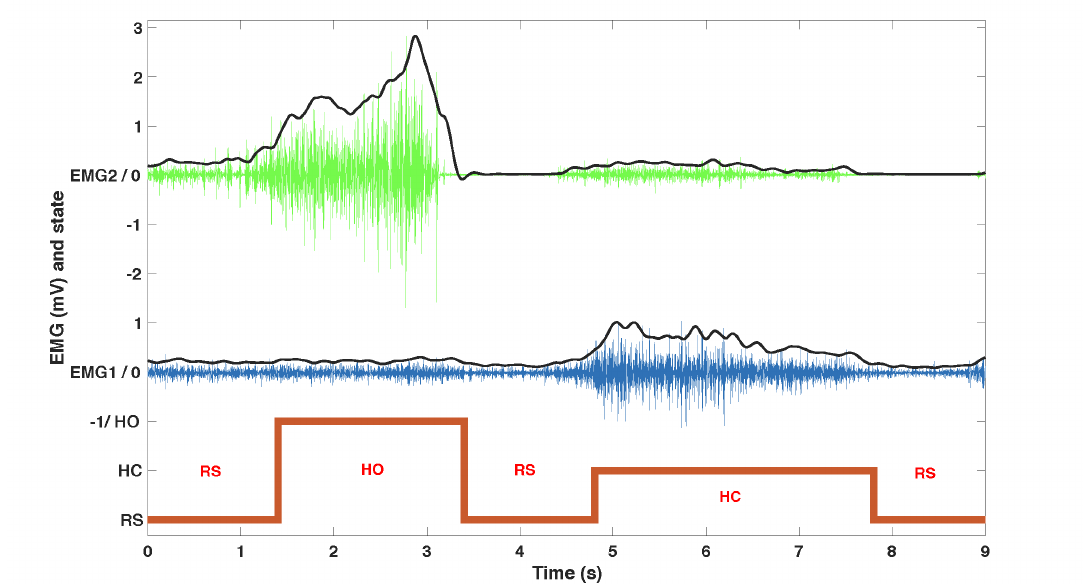
Figure 2. Representative example of EMG recordings with the automatic classification of states. Top: EMG 2. Middle: EMG 1. Bottom: actions (at-rest (RS), hand opening (HO) and hand closing (HC)). Black lines represent envelopes (their amplitude is multiplied by 4 for visualisation